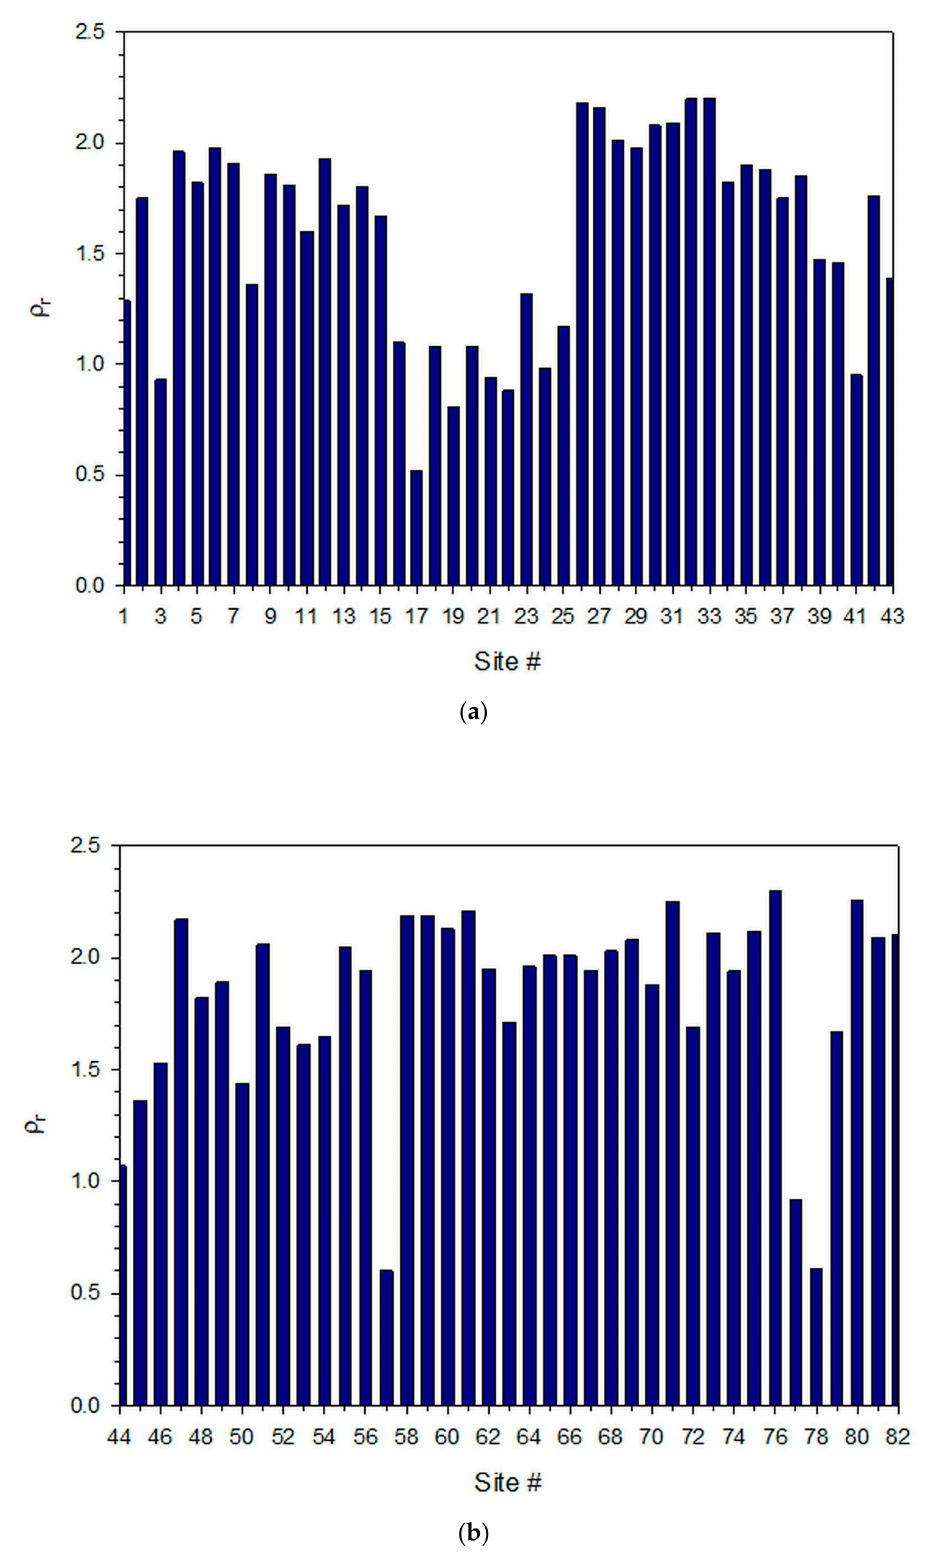
Figure 11. Annual mean ratios of ground albedo, ρ r , for the 82 sites in Saudi Arabia; ( a ) sites 1–43, ( b ) sites 44–82, averaged over the period 2005–2016. The site #24 has ρ r = 1, because its ρ g = ρ g0 =